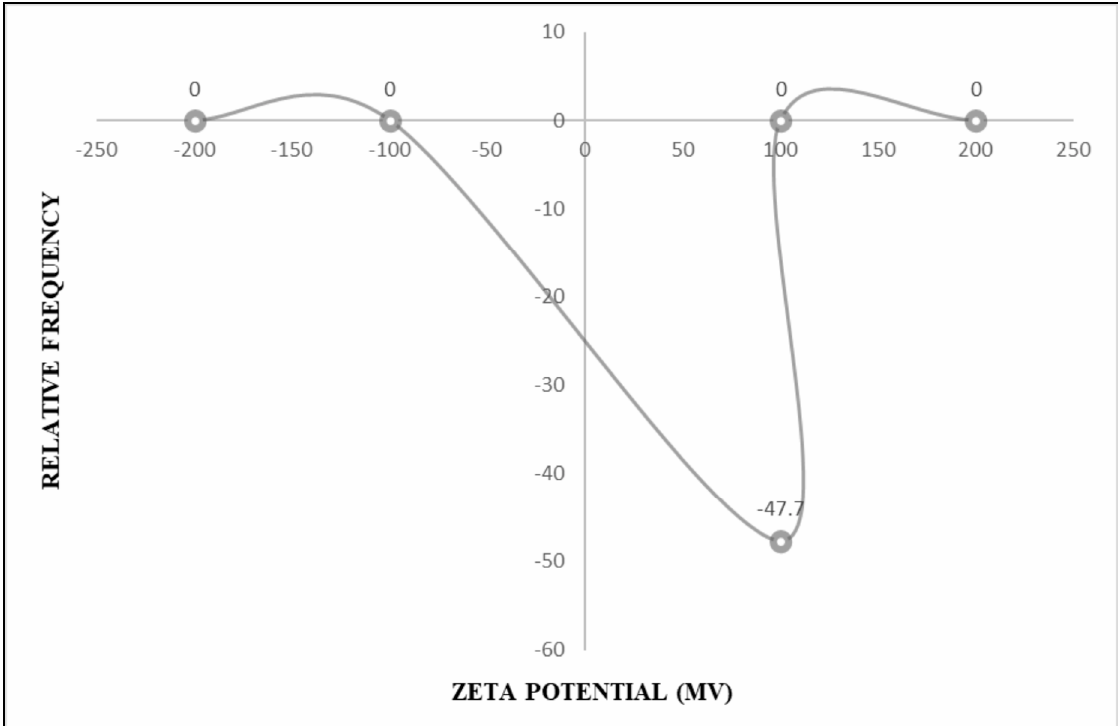
Figure 7. Effect of various temperatures on size of A. indica -based silver nanoparticles.